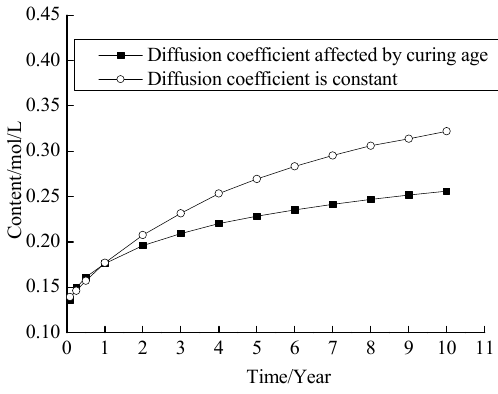
Figure 9. Concentration of chloride in 5cm.